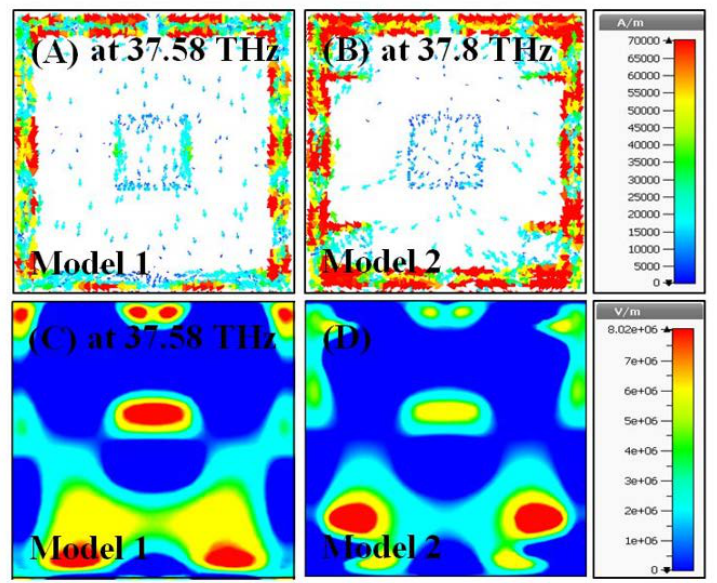
Figure 9. Color map of the field distributions for Model 1 and Model 2 ( A ) surface current at 37.58 THz for Model 1, ( B ) surface current at 37.8 THz for Model 2, ( C ) electric field at 37.58 THz for Model 1, ( D ) electric field at 37.8 THz for Model 2.